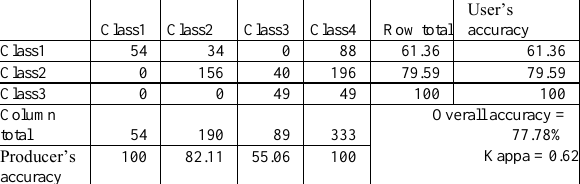
Table 3. Confusion matrix of the Maximum Likelihood